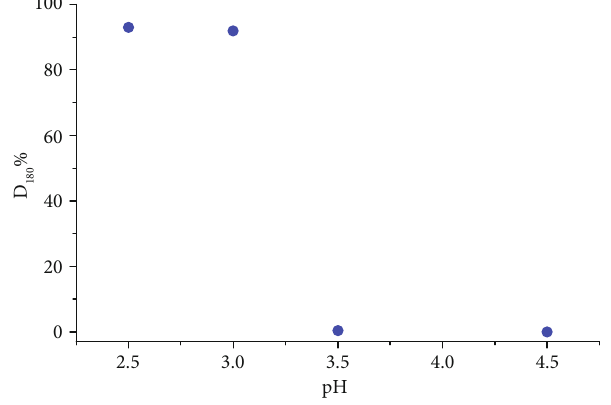
Figure 12: pH e ff ect on RB5 dye discoloration using ð MNZ/Fe Þ = 0 : 2 g/L as catalyst.